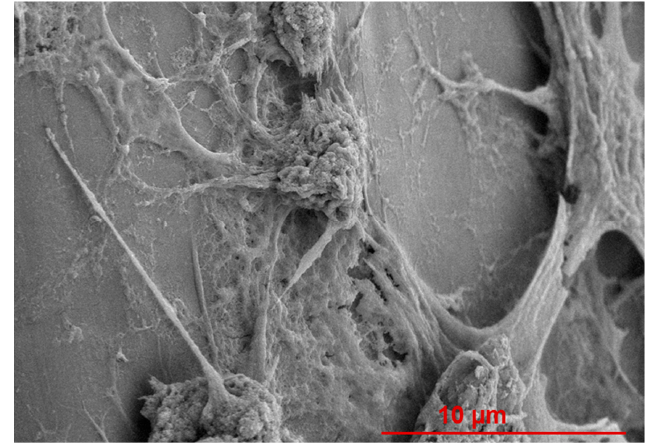
Figure 9. FESEM image at 5000× magnification taken from one random location for HL-1 cells exposed to a PCL+1.5G scaffold cultured under standard conditions for 3 days. SEM image was acquired at an acceleration voltage of 5 kV, under a low vacuum of 60 Pa combined with the backscattered electron detector, using a nominal spot size of 30 nm. Scale bar represents a 10 µ m distance within the image.